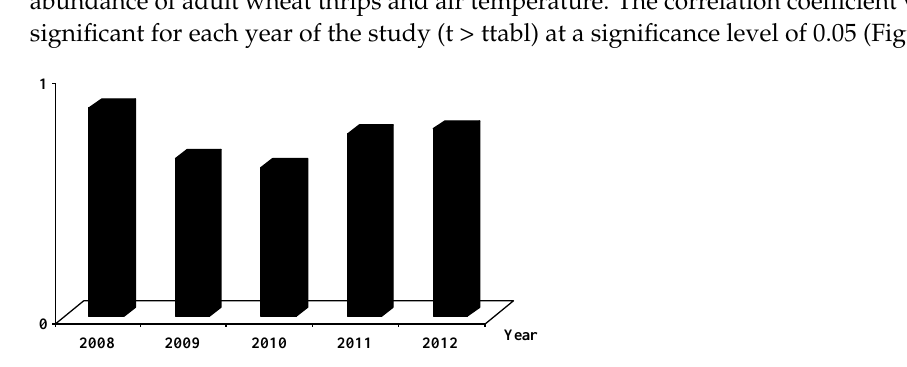
Figure 3. Correlation coefficients between abundance of adult wheat thrips and adult predatory and striped thrips in agrocenoses of wheat.